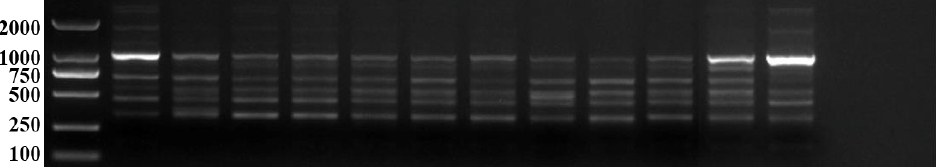
Figure 3. ISSR profiles of 54 R. communis L. samples amplified using primer UBC 842. The UPGMA dendrogram using ISSR data based on the genetic similarity coefficient showed two main clusters with the genetic similarity coefficient ranging from 0.74 to 0.96 with an average of 0.86 (Figure 4).